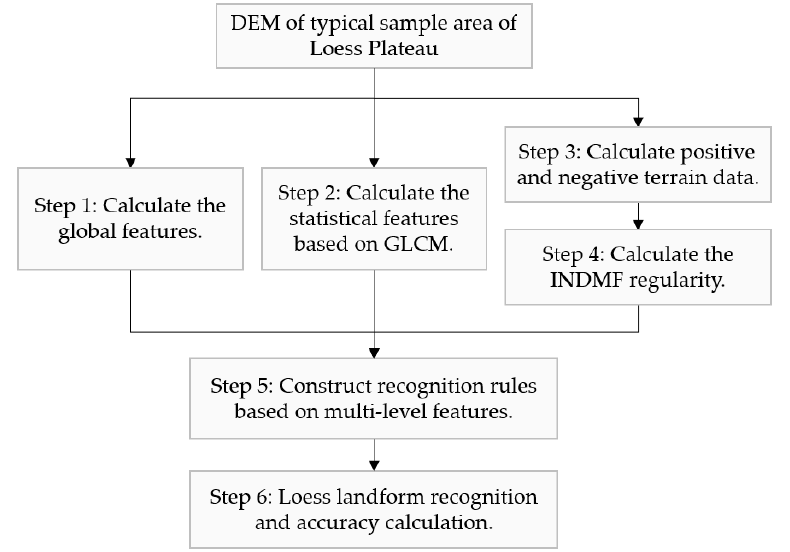
Figure 4. Flow chart of typical landform recognition of Loess Plateau combined with INDMF regu- larity.